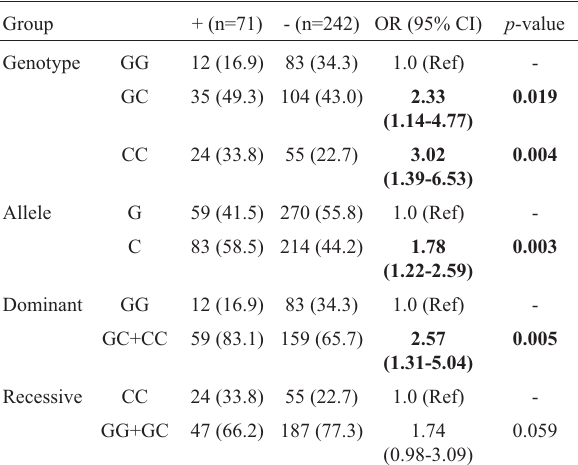
Table 5 - Association of rs1051169 polymorphism with neurologic disor- der